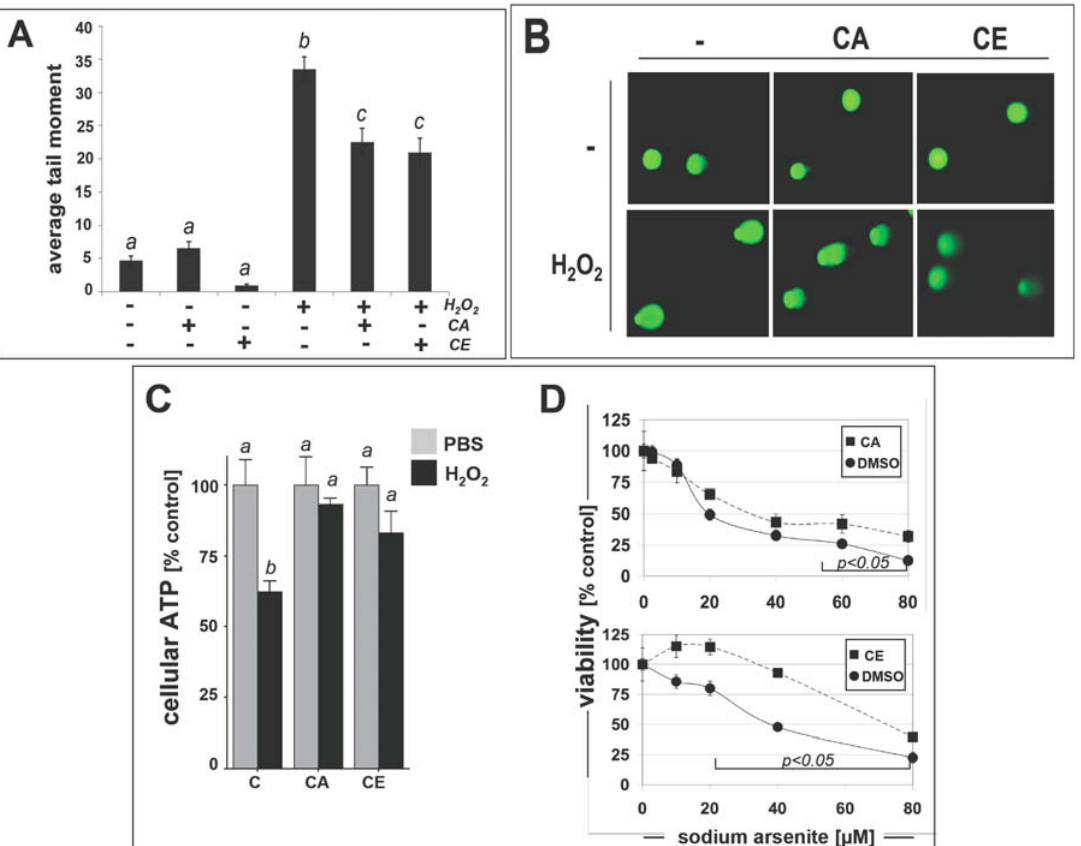
Figure 7. Pretreatment with cinnamic aldehyde or ethanolic cinnamon extract protects HCT116 colon cancer cells against oxidative stress-induced geno- and